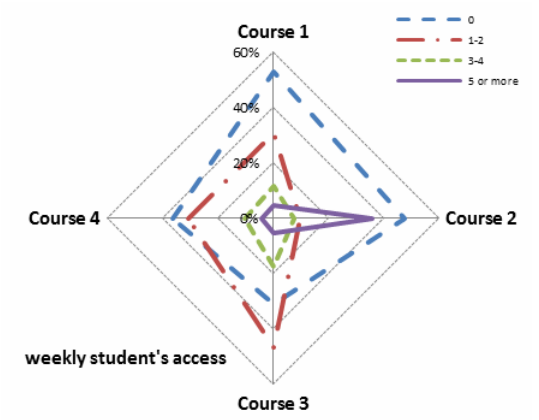
Figure 1. Characterization of weekly average frequency of accesses for each course.